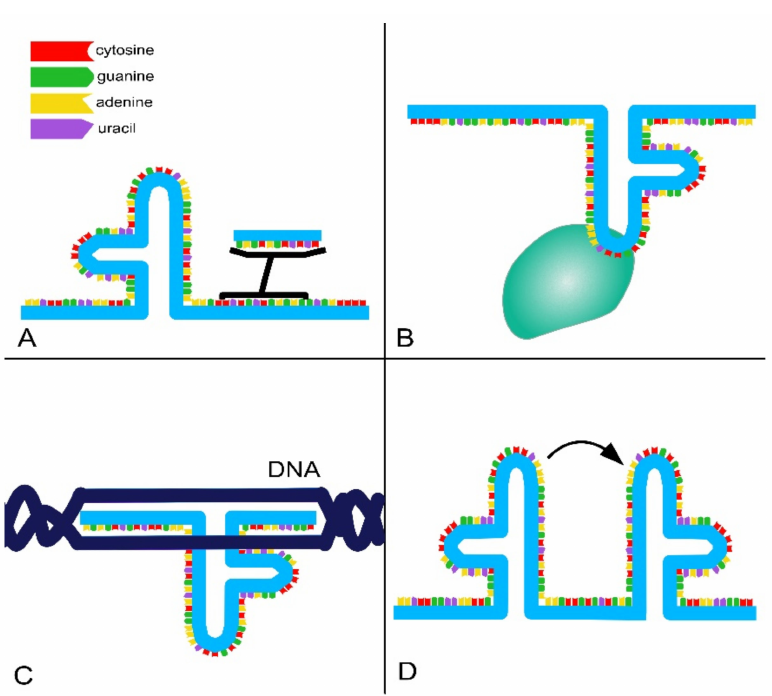
Figure 2. Domain architecture of lncRNAs. Schematic representation of lncRNAs’ structural domains, through which they can bind other RNAs via complementary base–pair interactions ( A ), proteins ( B ) and DNA ( C ). These interactions can induce allosteric, conformational changes to other structures in the lncRNA ( D